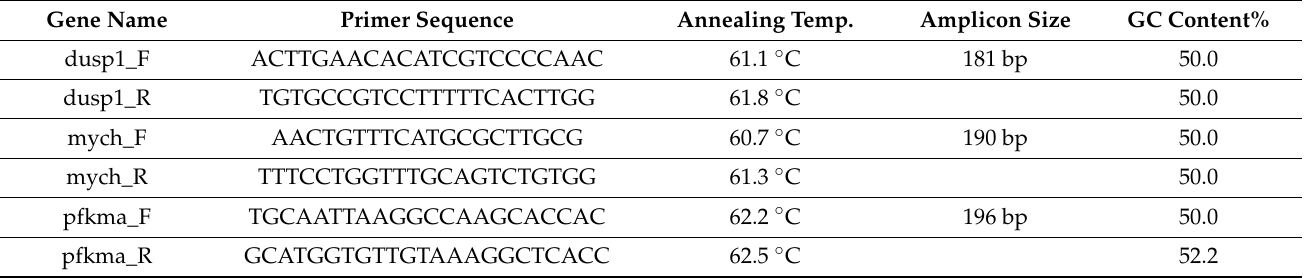
Table 1. Primer sequences for selected genes used during the RT-qPCR validation of the RNA-seq